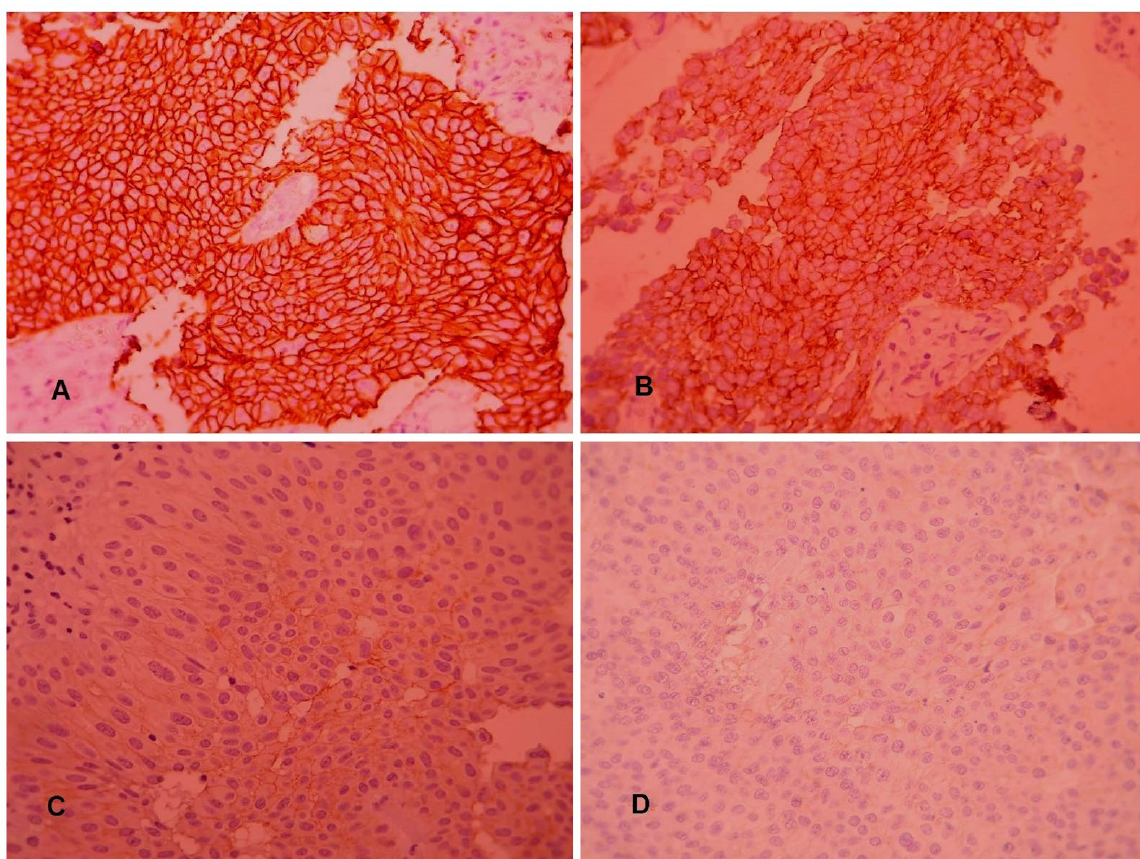
Fig. 1. Her2/neu IHC stain scoring in tumoral cells according to the Table 1: (A) score +3, (B) score +2, (C) score +1, (D) score 0.